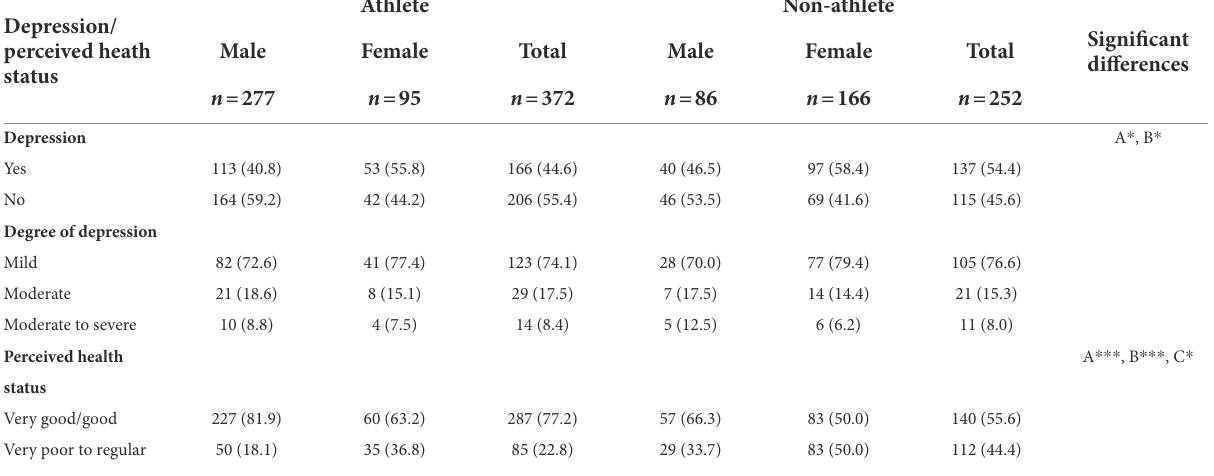
TABLE 3 Depression and perceived health status, n (%).